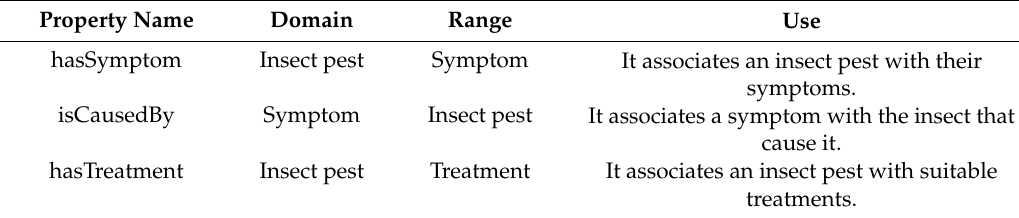
Table 3. Properties associated with the classes defined by